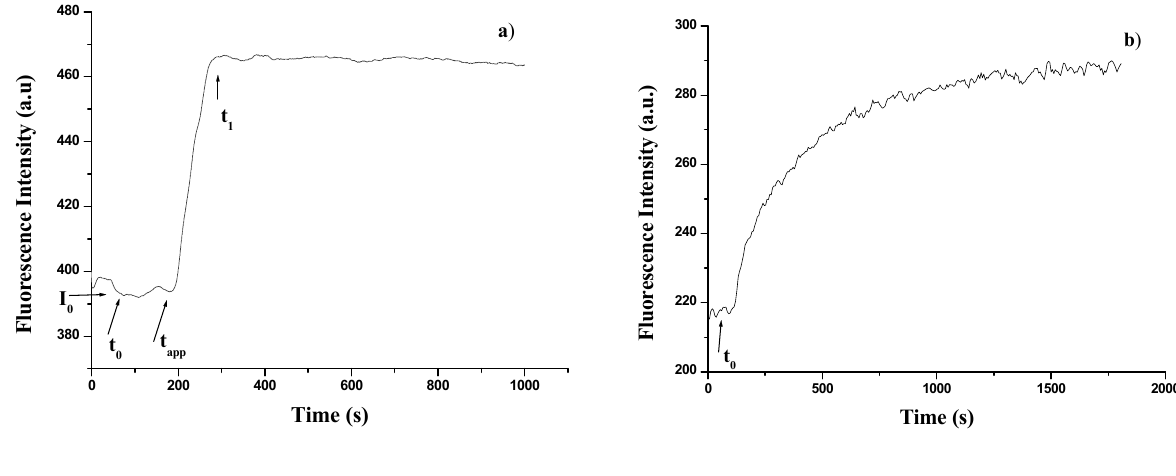
Figure 2. Fluorescence intensity as a function of time during the enzymatic reaction: (a) free GOD (0.2 mM glucose concentration); (b) immobilized GOD (2 mM glucose